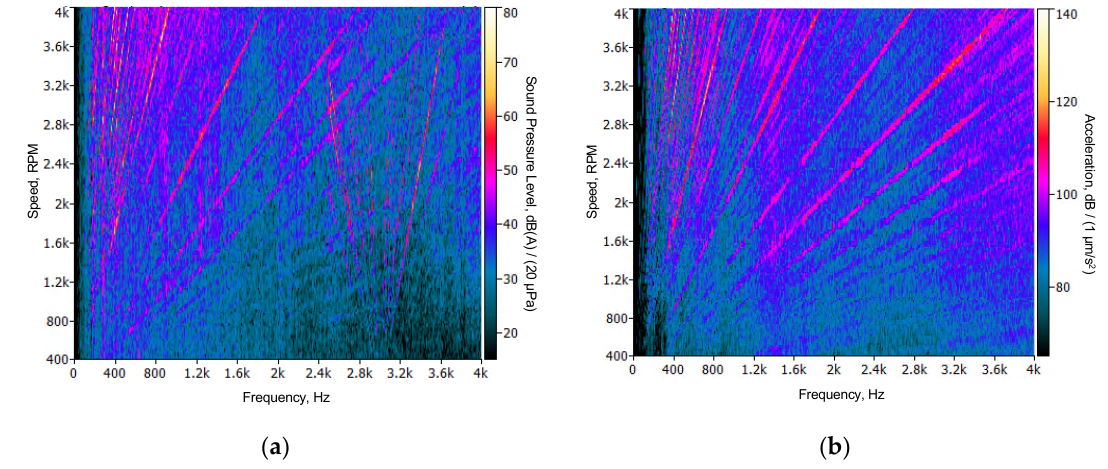
Figure 4. Results of the noise and vibration measurement. ( a ): Sound pressure level; ( b ): Acceleration level.